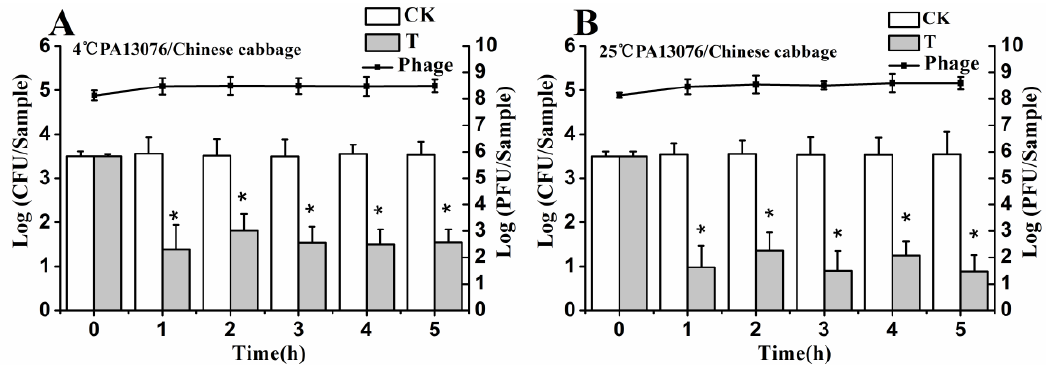
Figure 6. Figure 6. Cont. Figure 6. Cont.